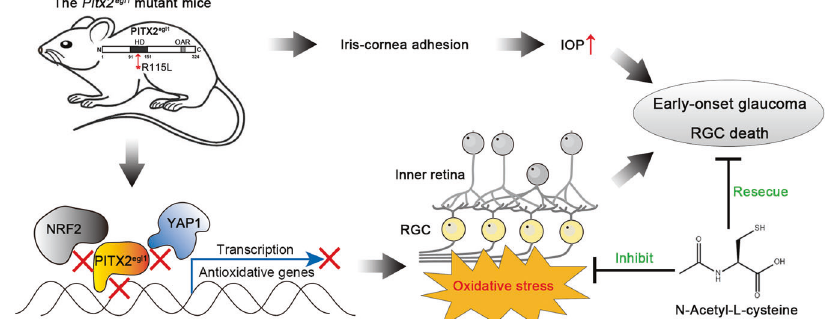
Fig. 7 Treatment with N-Acetyl-L-cysteine prevents elevated intraocular pressure-induced retinal injury by inhibiting oxidative stress in Pitx2 KI mutant retinas. A N-Acetyl-l-cysteine in 40% PBS was injected intraperitoneally (25 mg/kg/day) into Pitx2 WT and Pitx2 KI mutant mice for 5 weeks (from 5-week to 10-weeks of age) as the treated groups. Equivalent volumes of 40% PBS were delivered intraperitoneally to the Pitx2 WT and Pitx2 KI mice as the vehicle-treated control groups. All animals were sacri fi ced at 10 weeks of age to conduct analyses. B IOP analysis in Pitx2 WT and Pitx2 KI mice subjected to vehicle and N-Acetyl-l-cysteine treatment. Individual IOP values are shown by dots in the histograms ( n = 10 in each group). C ROS activity was measured by DHE staining of retinal sections from Pitx2 WT and Pitx2 KI mutant mice subjected to vehicle or N-acetyl-l-cysteine treatment. The red staining is positive for ROS content. Nuclei were counter-stained with DAPI (blue). Scale bars: 50 μ m. D Quanti fi cation of the fl uorescence intensity of DHE staining showed an obvious decrease in ROS formation in retinas from treated- Pitx2 KI mutant mice ( n = 10 in each group). E Representative images of H&E staining of retinal section from Pitx2 WT and Pitx2 KI mice subjected to vehicle or N-Acetyl-l-cysteine treatment. Scale bars: 25 μ m. OS, outer segment; IS, inner segment; ONL, outer nuclear layer; INL, inner nuclear layer; GCL, ganglion cell layer. F Quanti fi cation of the nuclei number in GCL shows that the Pitx2 KI mutants have signi fi cantly decreased number of nuclei in the GCL ( n = 6 in each group). G Immuno fl uorescent enface view of retinal fl atmounts from vehicle- or N-Acetyl-l- cysteine-treated Pitx2 WT and Pitx2 KI mice following labeling with anti-Brn3a to detect RGC. Scale bars: 25 μ m. H Quanti fi cation of the number of RGC showed overall decreased number of RGL Brn3a positve cells. However, comparison of Pitx2 KI vehicle group, Pitx2 KI treated group showed signi fi cantly more RGC remaining in N-Acetyl-l-cysteine-treated Pitx2 KI mice ( n = 12 in each group). I Quantitation indicates that an obvious increase in Δ RGC number in Pitx2 KI retinas ( n = 10 in each group). Δ RGC number = RGC number (Treated group) – RGC number (vehicle